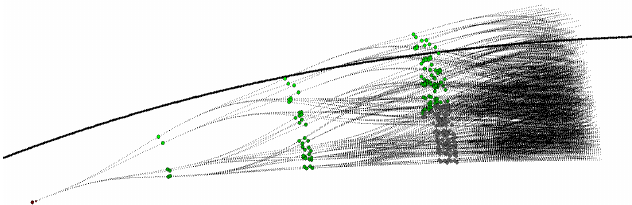
Figure 5. A random tree exploring the area around a given curved trajectory. The degree of the tree D and its height H are equal to 4. The car is initially placed at the center of the lane and its target is to converge on the specified path (black line). To have an idea of the convergence speed, the lane is 6 m wide and the trajectory about 40 m